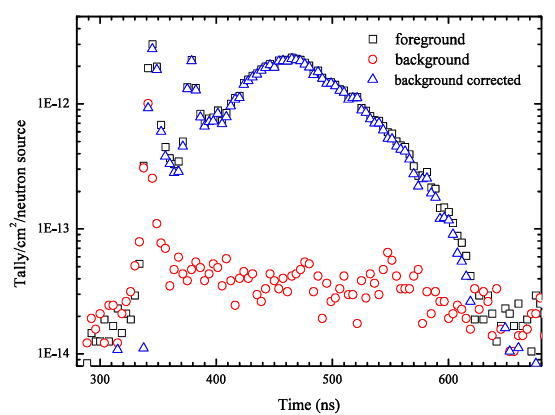
Table 1. The compositions of the sample(in weight).